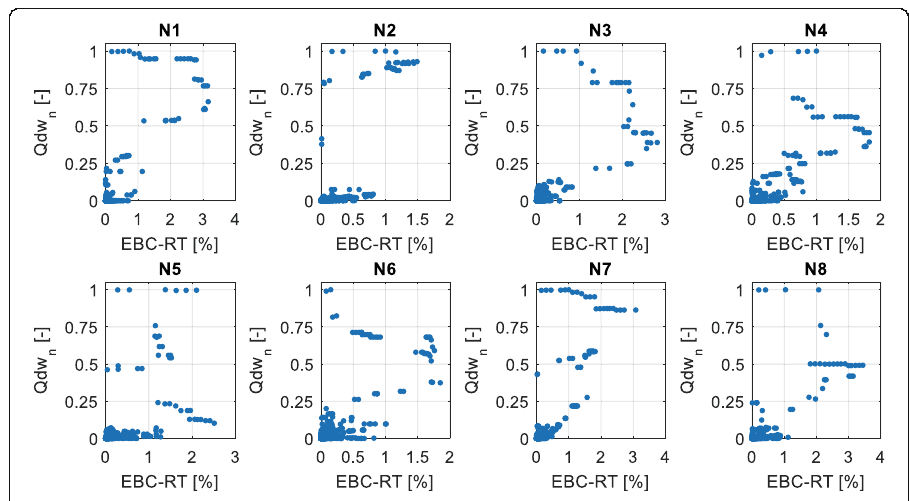
Fig. 4 Relationship between Qdw n and EBC-RT, for 8 subnetworks of Dresden ’ s sewer system